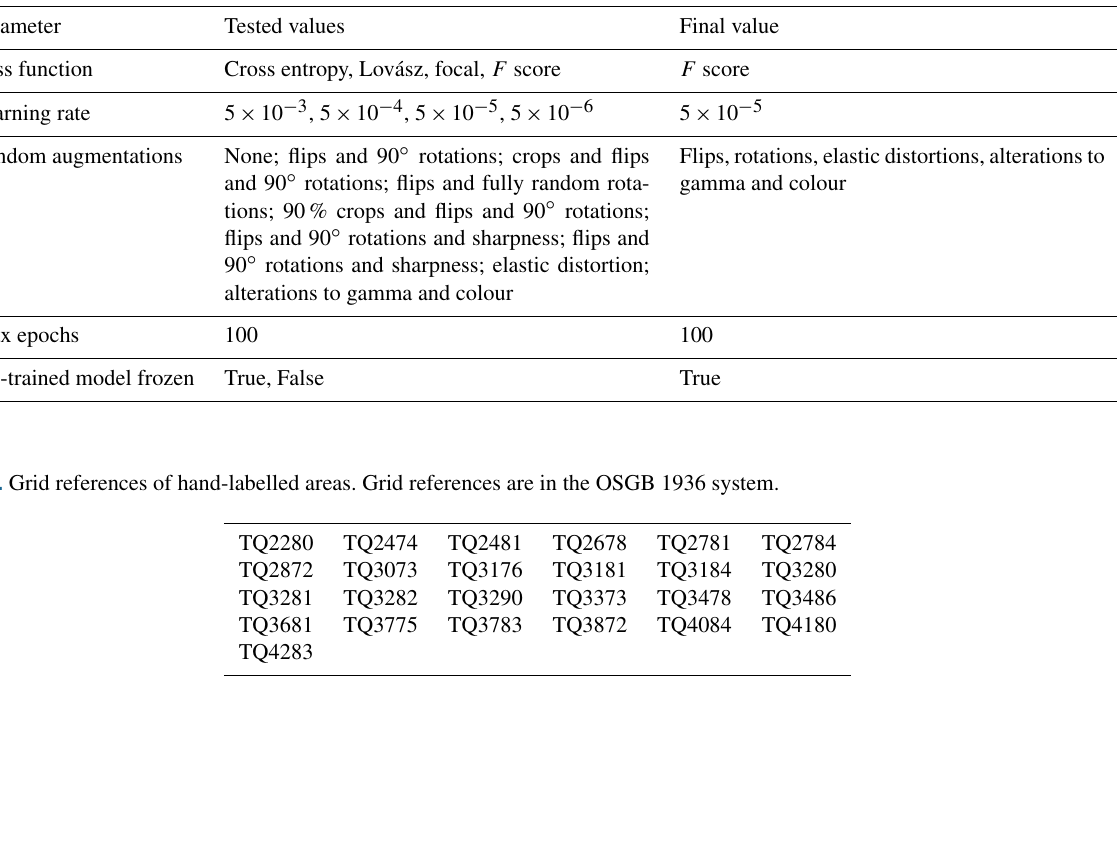
Table A1. Table listing the hyperparameters that were tuned, which values were tested, and the final value used for classification.